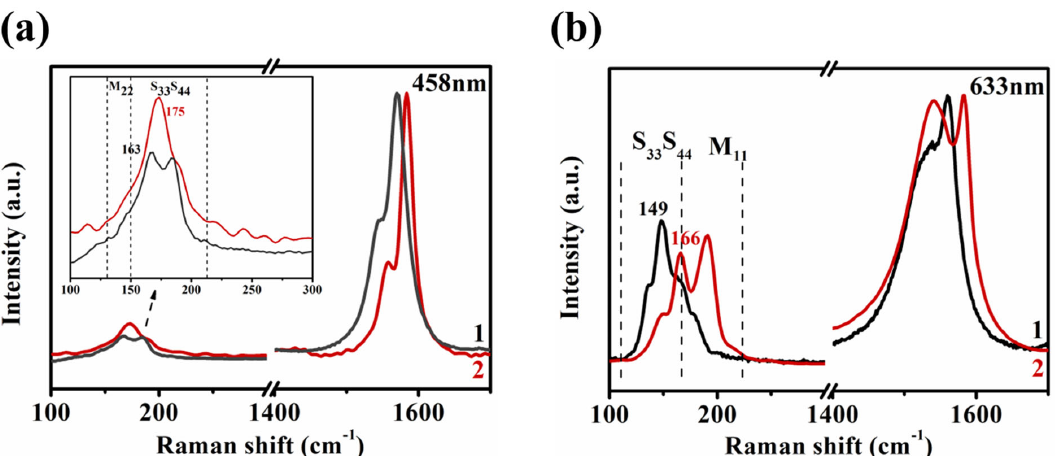
Figure 4. Resonance Raman spectra of the primarily purified SWNTs (line 1) and BA–PMS–dispersed SWNTs (line 2) under excitations with ( a ) 458 and ( b ) 633 nm lasers, respectively.